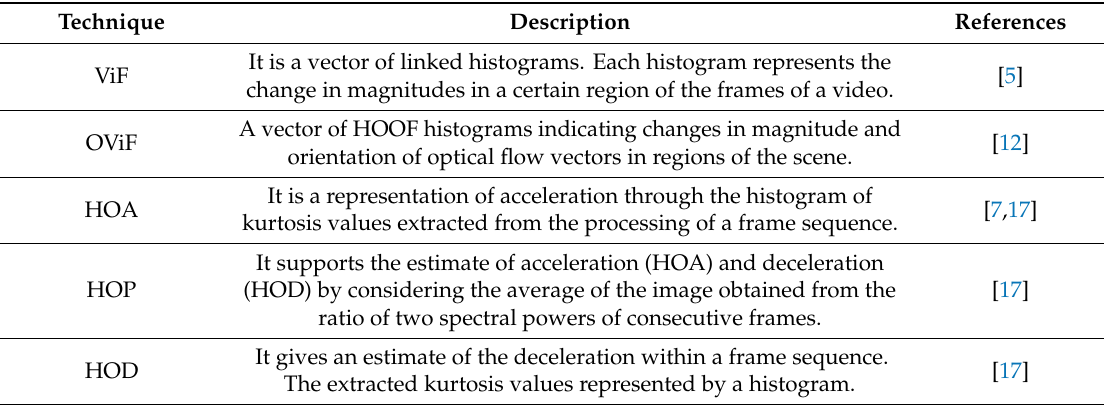
Table 2. Summary of the analyzed features for violence detection.